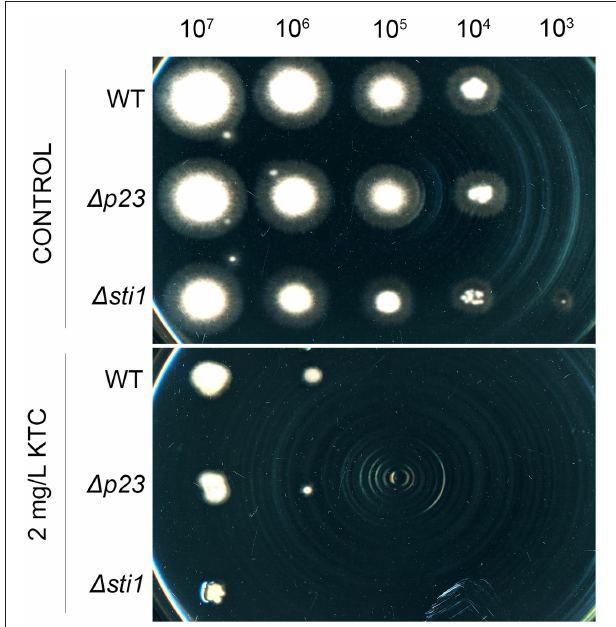
FIGURE 6 | The Fusarium verticillioides sti1 homolog FVEG_00423 and p23 homolog FVEG_11505 knockout mutants were hypersensitive to ketoconazole (KTC). Two microliters of conidial suspensions of different concentrations (1 × 10 7 , 1 × 10 6 , 1 × 10 5 , 1 × 10 4 , and 1 × 10 3 conidia/ml) were inoculated onto the plates ( 8 150mm) of potato dextrose agar medium with or without 2mg/L KTC, and incubated at 28 ◦ C for 72 h. Each test had three replicates and the experiment was independently repeated